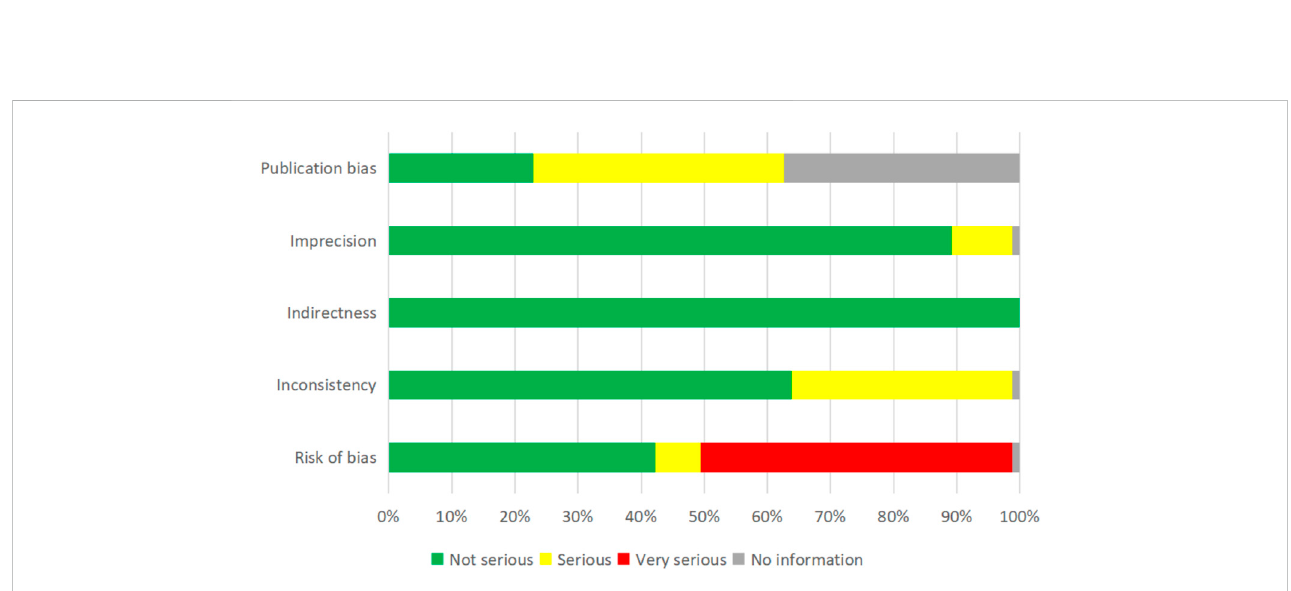
Evidence certainty based on the GRADE